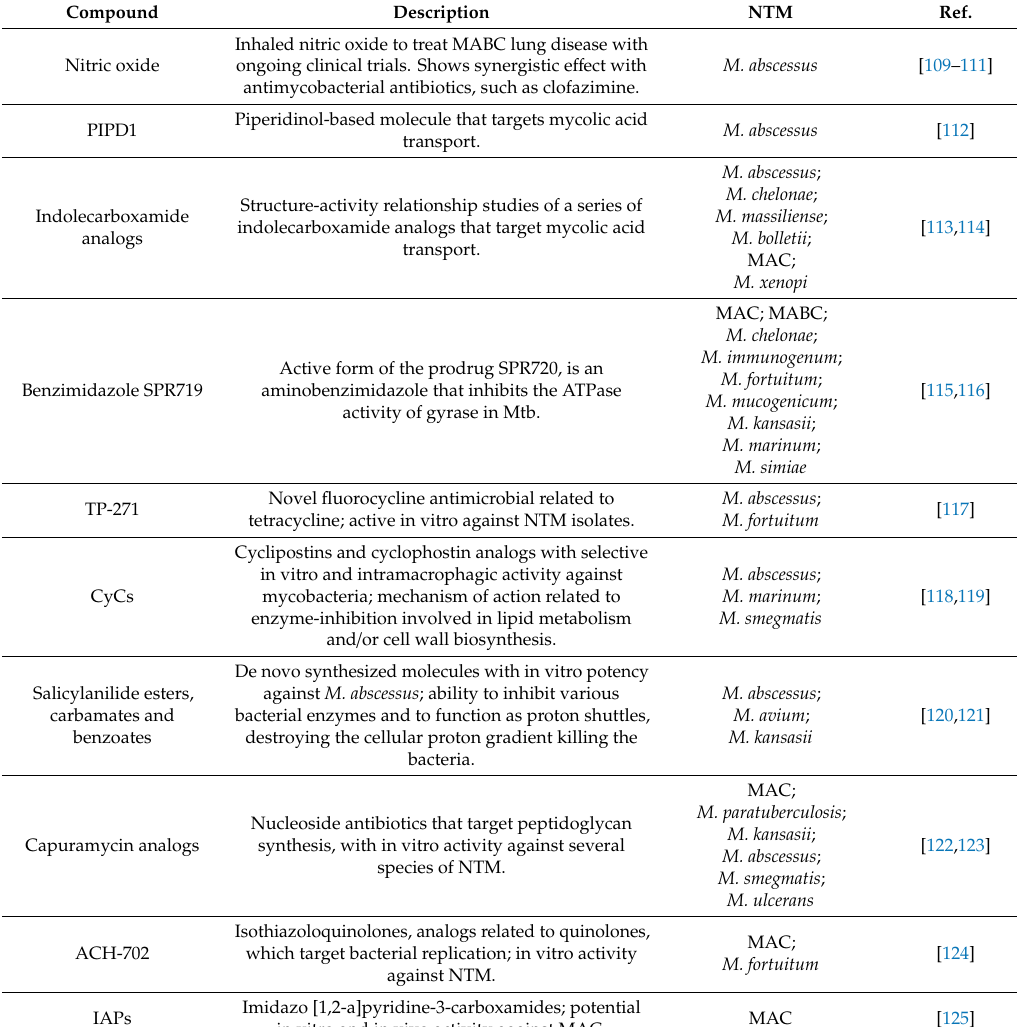
Table 1. Summary of recent publications showing new, promising antimicrobial agents against NTM